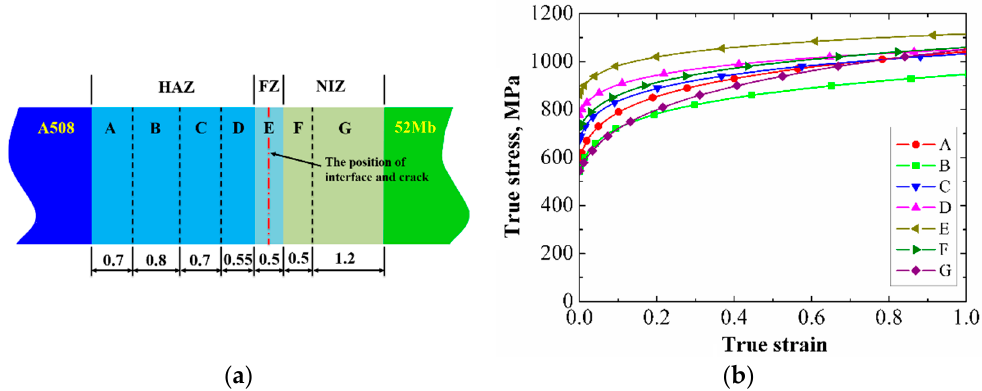
Figure 2. Different subareas in the A508/52 Mb interface region ( a ) and the true stress-strain curves of different subareas ( b ) [31].